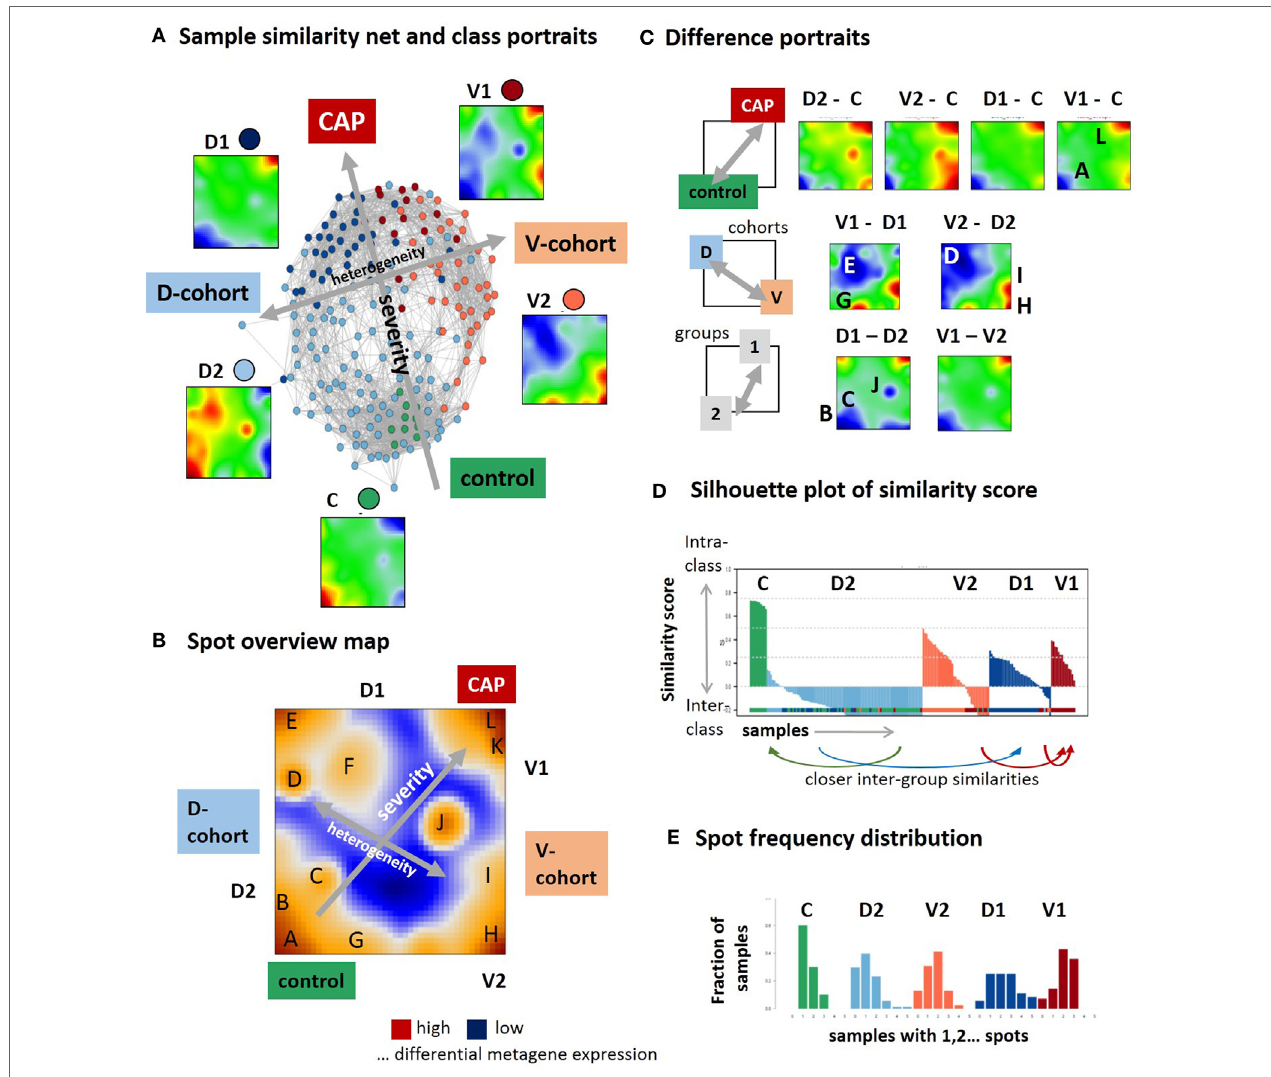
FigUre 1 | Self organizing map (SOM) portrayal of the blood transcriptome of community-acquired pneumonia (CAP). (a) The sample similarity (correlation) network and the mean expression portraits of the five sample groups, healthy control (c) , discovery cohort groups 1 and 2 (D1 and D2), and validation cohort group 1 and 2 (V1 and V2) reveal two major dimensions of diversity (arrows). (B) The expression variance map indicates 12 major spots (A–L) of co-expressed genes. (c) Difference portraits between the sample groups reveal modes of differential expression. (D) The similarity score describes the similarity of each sample to its own cluster. Negative scores indicate that the sample is more similar to other clusters. The figure shows that D2 is an unspecific group for which most of the samples are more similar to C and D1 (see arrows) while C and V1 are specific groups. (e) The spot frequency distributions indicates that sample SOM portraits express more spots in direction from the left to the right, thus reflecting a larger heterogeneity of transcriptional programs activated in CAP compared with the